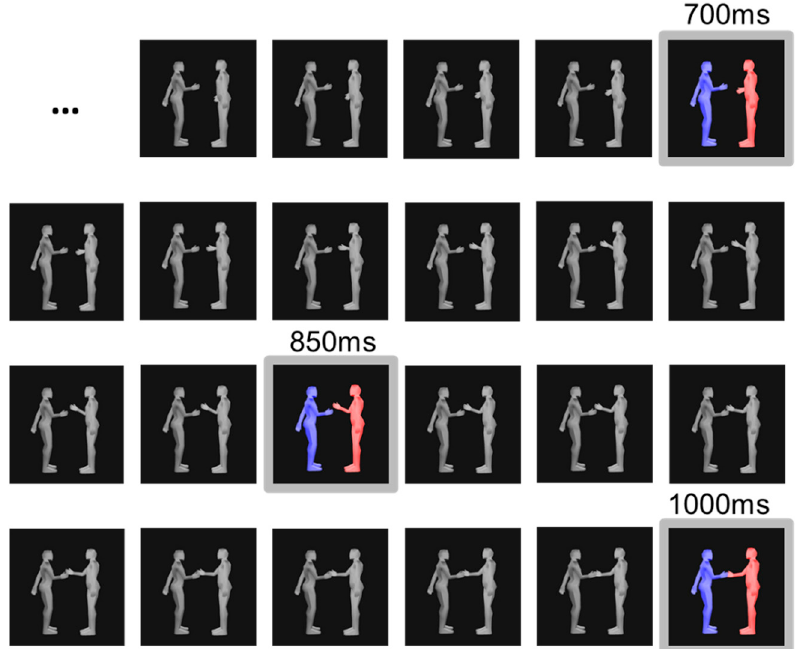
Figure 2. Example of a reaction frame sequence at 60 fps. Coloured frames represent the different still frames at 700 ms, 850 ms and 1000 ms. The grey frames were occluded.